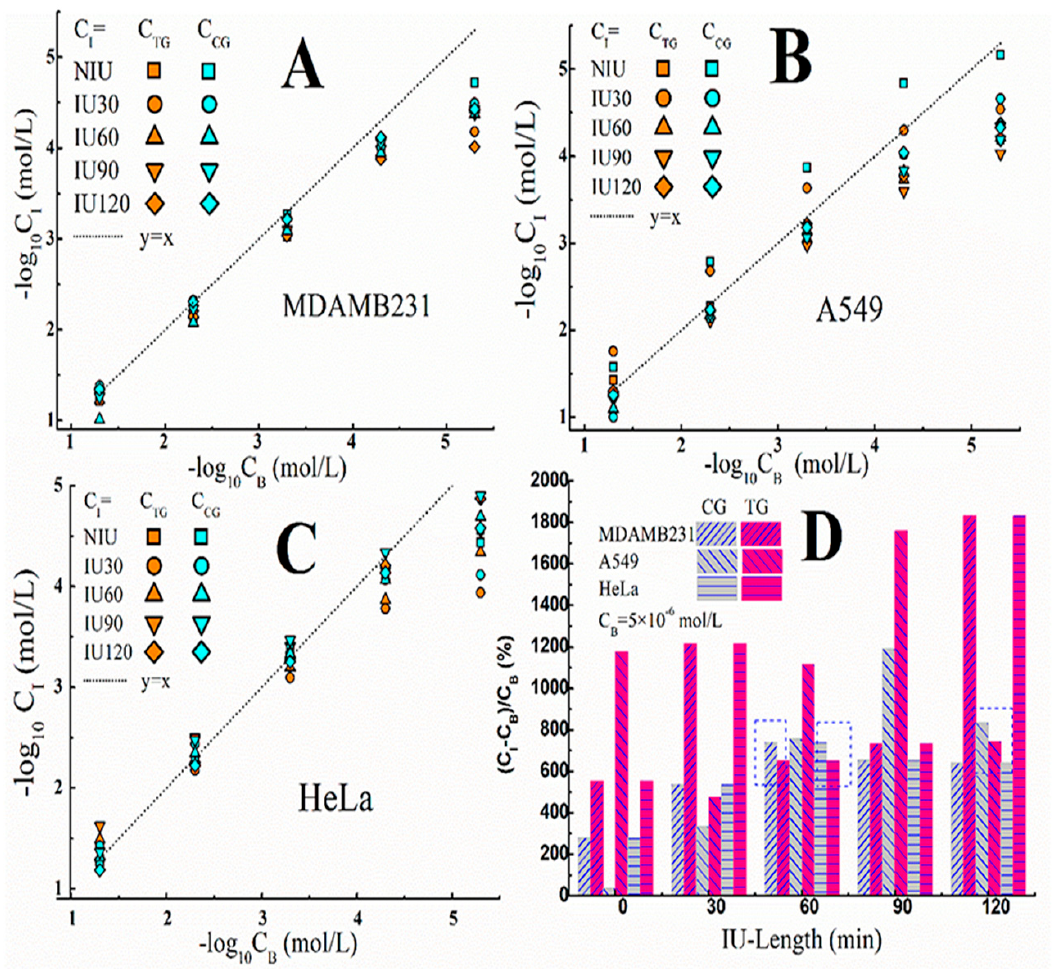
Figure 5. The comparisons of the deduced I - concentrations in IME (C I ) from Figure 3 in relation with the applied background I - concentration (C B ). ( A )–( C ) The data for the cells of MDAMB231, A549 and HeLa, respectively. ( D ) The deviation ratios between C I and C B caused by TG and CG cells.